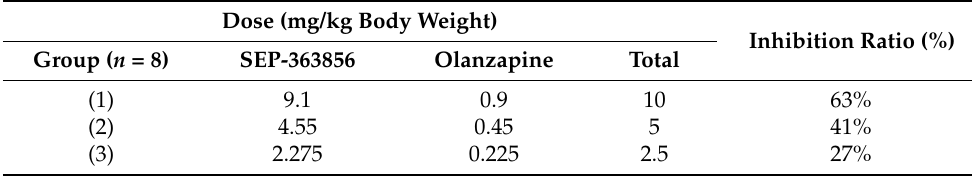
Table 1. ED 30 used in the interaction between SEP-363856 and olanzapine before administration of